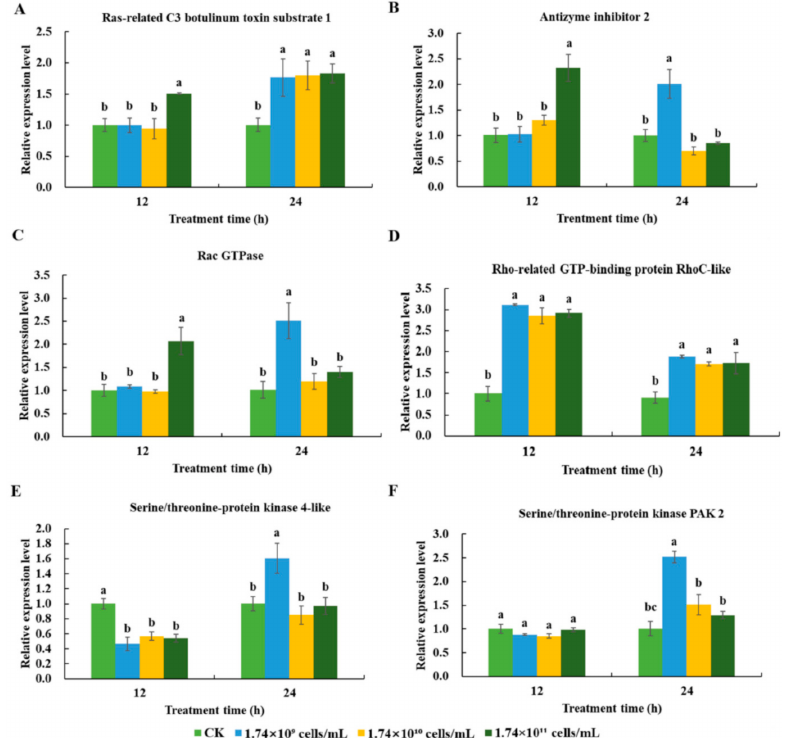
Figure 5. The expression profiling of six cellular immunity- related genes in R. chinensis infected with SM1. In the figure, the same lowercase letters indicate that they were not significantly different in gene expression at the same time, but at different treatment concentrations. ( A ) Ras-related C3 botulinum toxin substrate 1; ( B ) Antizyme inhibitor 2; ( C ) Rac GTPase; ( D ) Rho-related GTP-binding protein RhoC-like; ( E ) Serine/threonine-protein kinase 4-like; ( F ) Serine/threonine-protein kinase